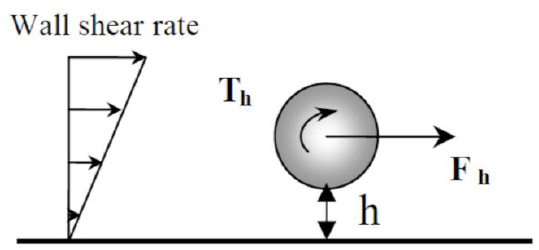
Figure 3. Particles are subjected to torque and to a translational movement near the wall (top view).